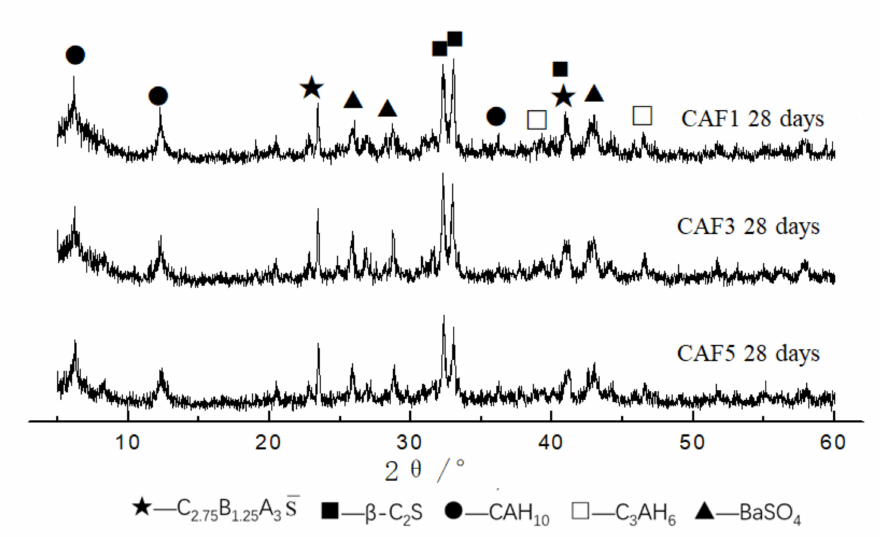
Figure 9. XRD patterns of different hydrated samples at 28